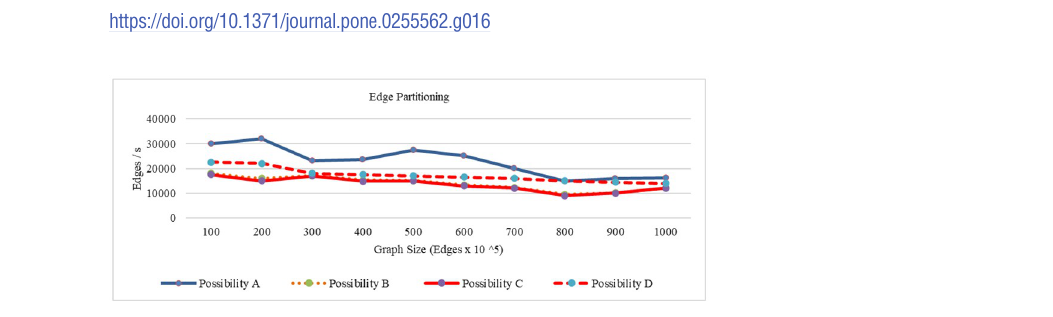
Fig 16. Latency time using vertex partitioning.